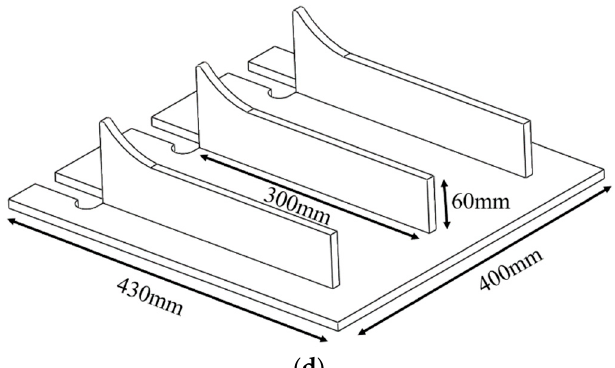
Figure 5. Four types of ship welded structures: ( a ) welded structure 1; ( b ) welded structure 2; ( c ) welded structure 3; ( d ) welded structure 4.